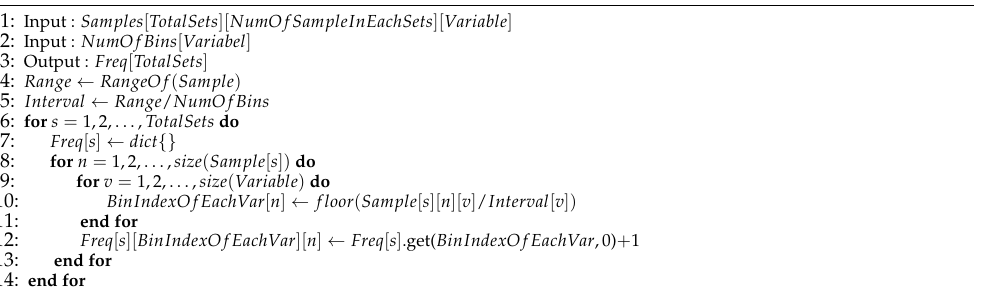
Algorithm 1 Serial Version of the Multi-set Histogram